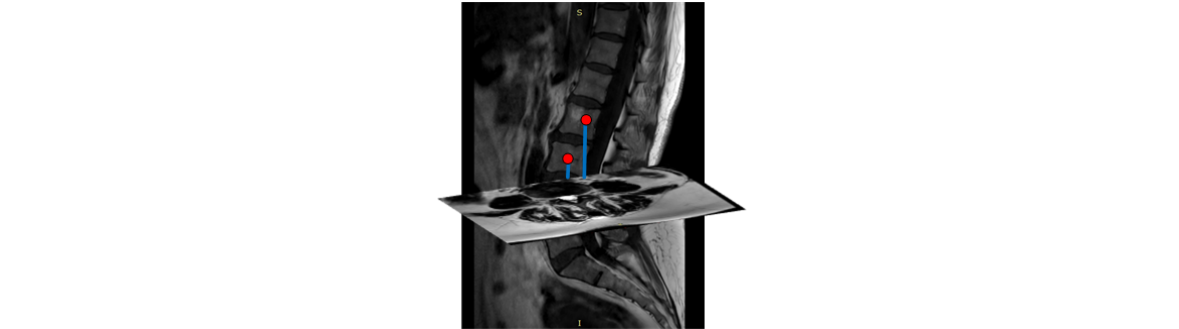
Figure 3. The intervertebral disks (from L1-L2 to L5-S1) in each axial image were located by calculating directed distances. The red dot shows the middle point of each vertebral body in a sagittal image. The blue line depicts the directed distance from the red dot to a specific axial image. L: lumbar vertebra; S: